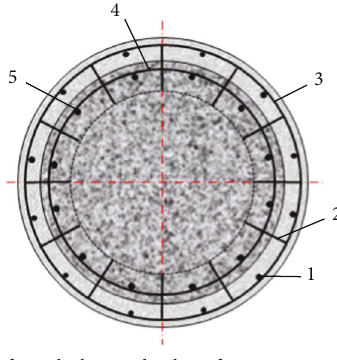
Figure 6: New column parameter